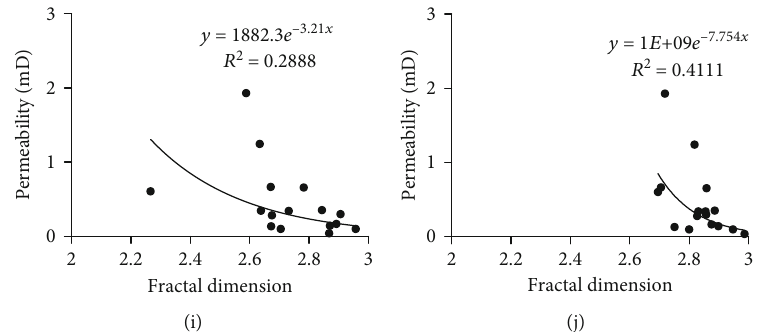
Figure 8: Correlations between fractal dimensions and physical properties. ((a – e) represent porosity while (f – j) represent permeability. Figures from the left to the right represent D i